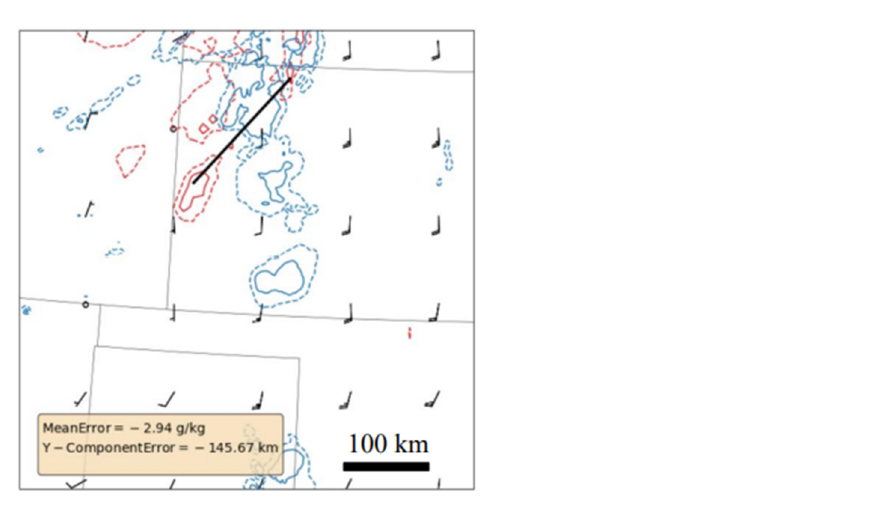
Figure 4. Type C case on 28 June 2014 at 0100 UTC, near the time of initiation. Red contours are mosaic composite reflectivity above 25 dBZ (dashed) and 40 dBZ (solid). Blue contours and wind barbs are WRF output with the Mellor-Yamada-Janjic (MYJ) scheme, with blue contours being composite reflectivity above 25 dBZ (dashed) and 40 dBZ (solid), and wind barbs representing the 750 m AGL wind. Bottom left corner displays the specific humidity mean error, and the Y-component displacement error (based on centroids of the 40 dBZ region), with the total displacement represented by the black line. Distance scale is shown in lower right. Table 2. As in Table 1 except for WRF runs using